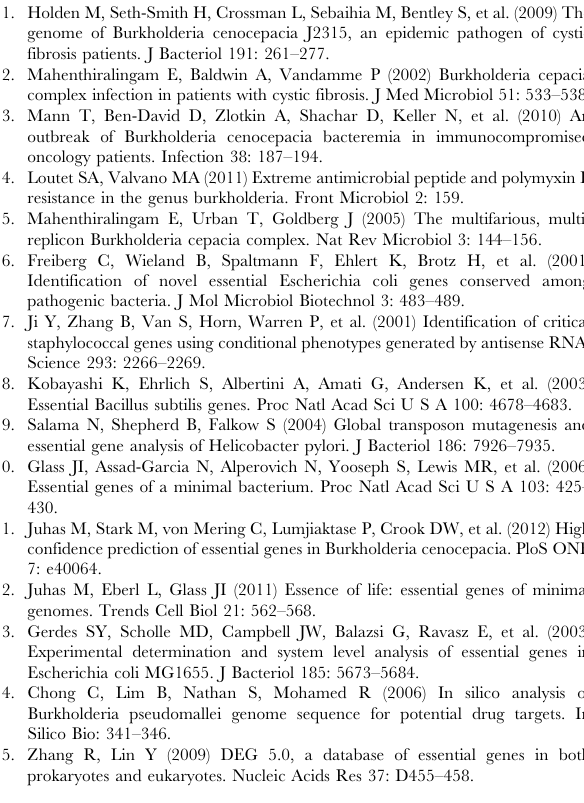
Table S2 Burkholderia protein structures (expanded version). Table S3 Structural characteristics of proteins report-